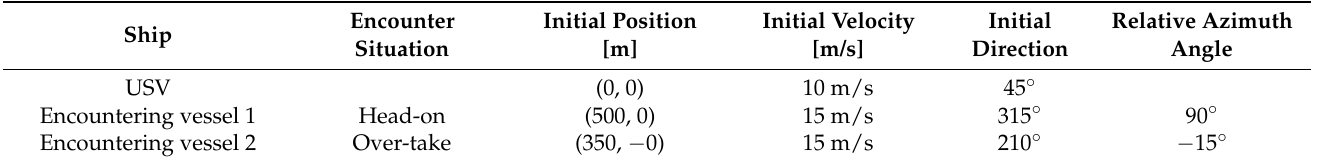
Table 10. Settings of encounter scene